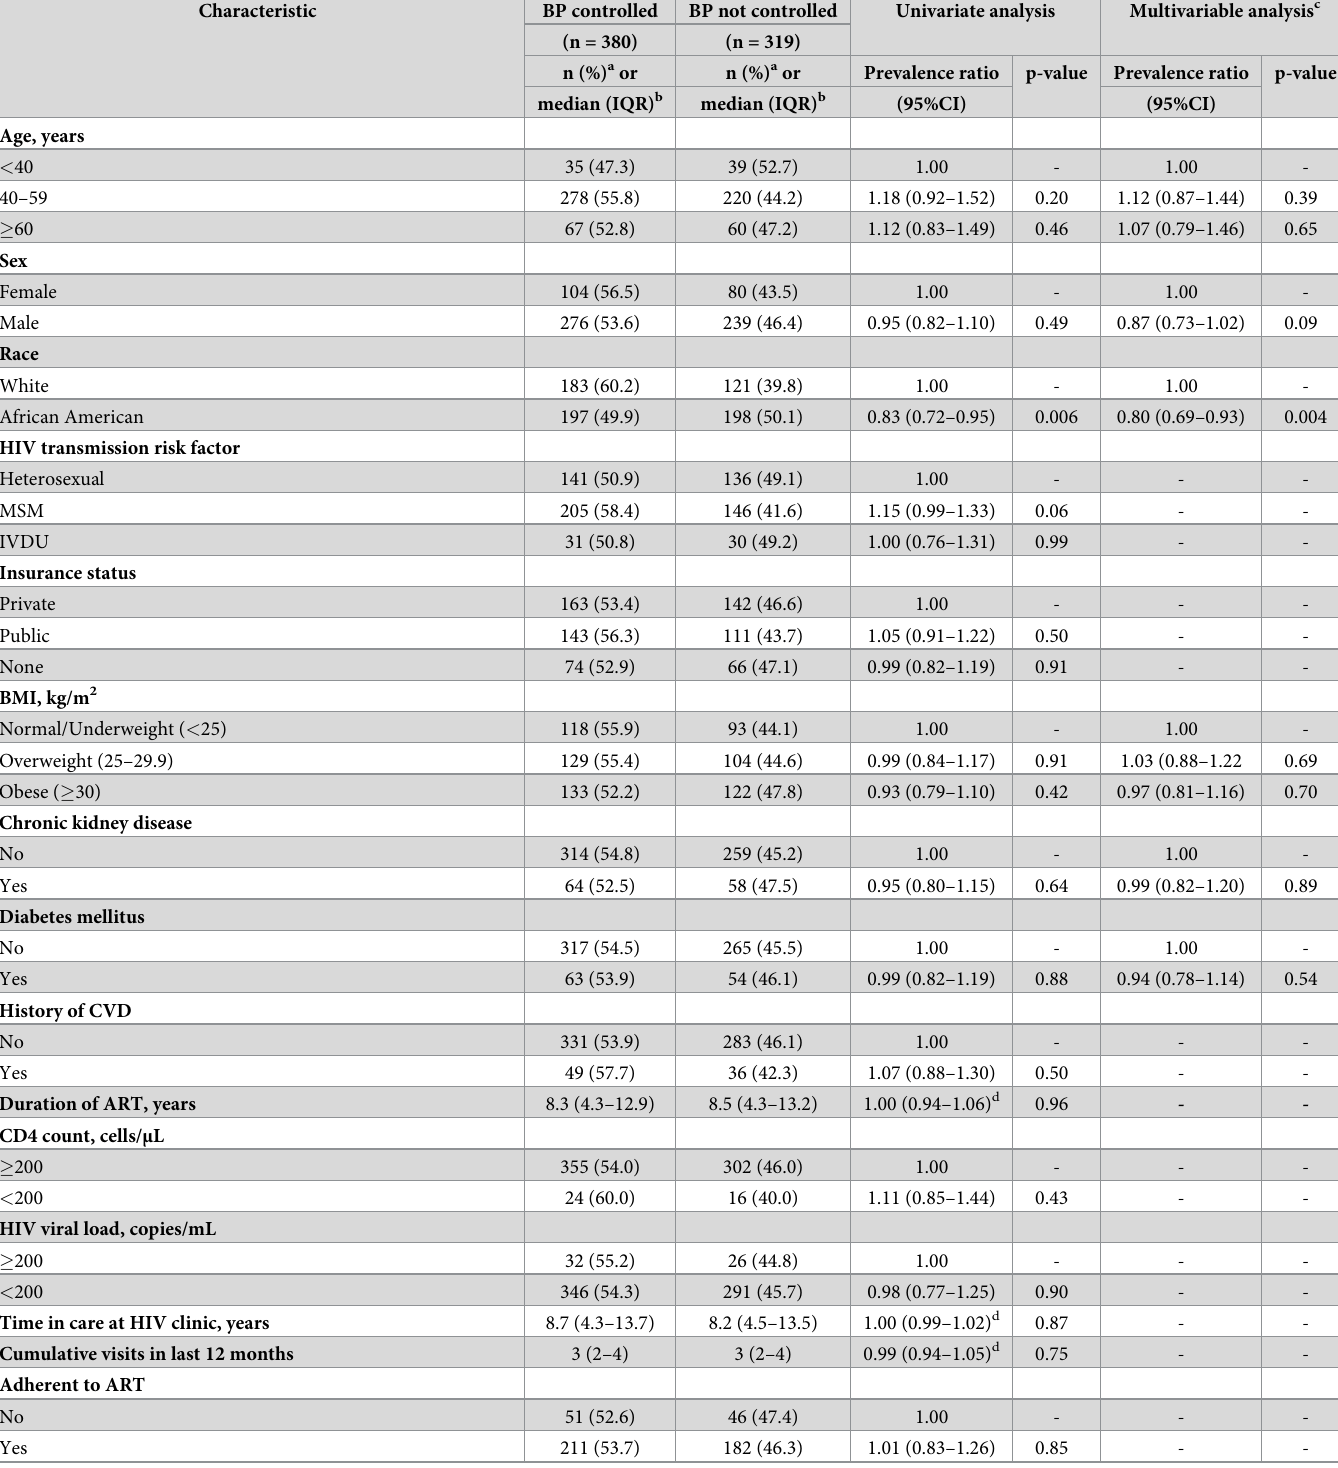
Table 3. Characteristics associated with blood pressure control among 699 HIV-infected patients on antihypertensive medication attending the UAB 1917 HIV Clinic in 2013. Characteristic BP not